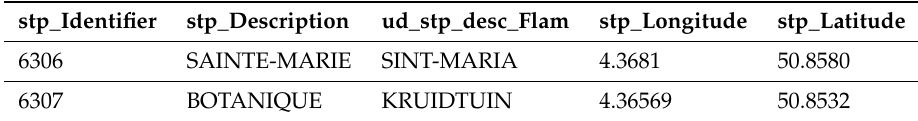
Figure 2. Relation between STIBroute components. Table 4. Sample of the Stop table.